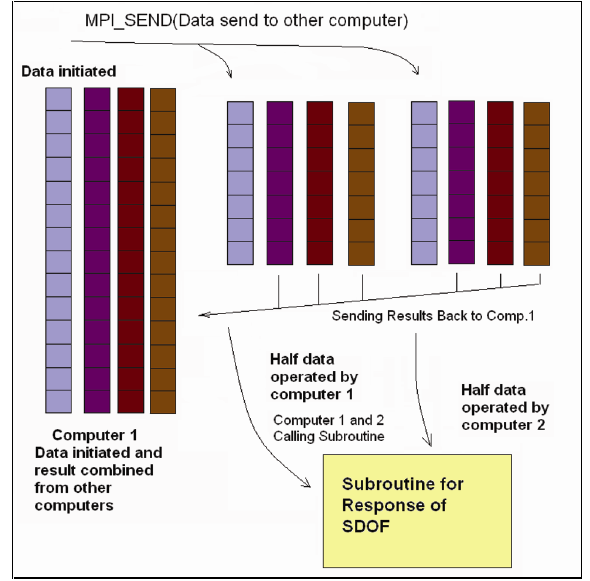
Fig. 4. Schematic representation of Parallel Program for respon- se of SDOF